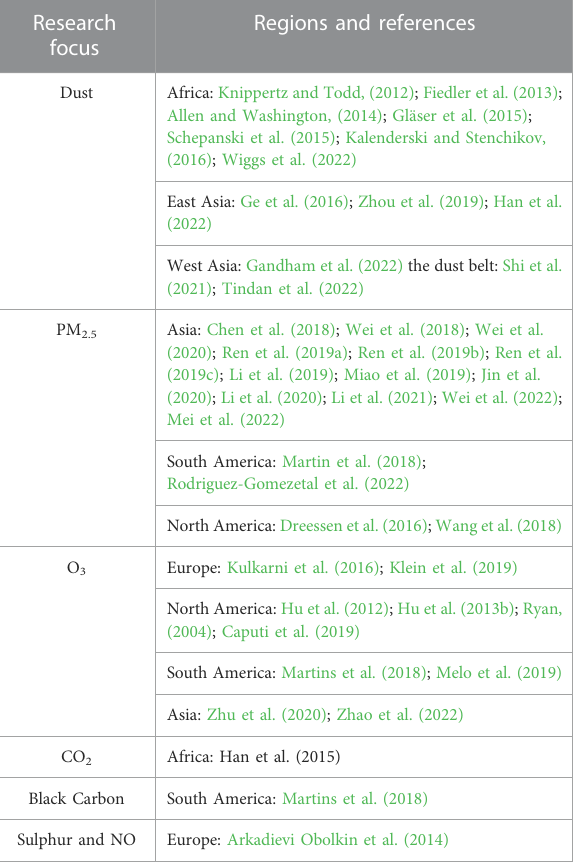
TABLE 1 Summary of main studies (mostly after 2012) on the LLJs and chemical species transport in different regions. Research